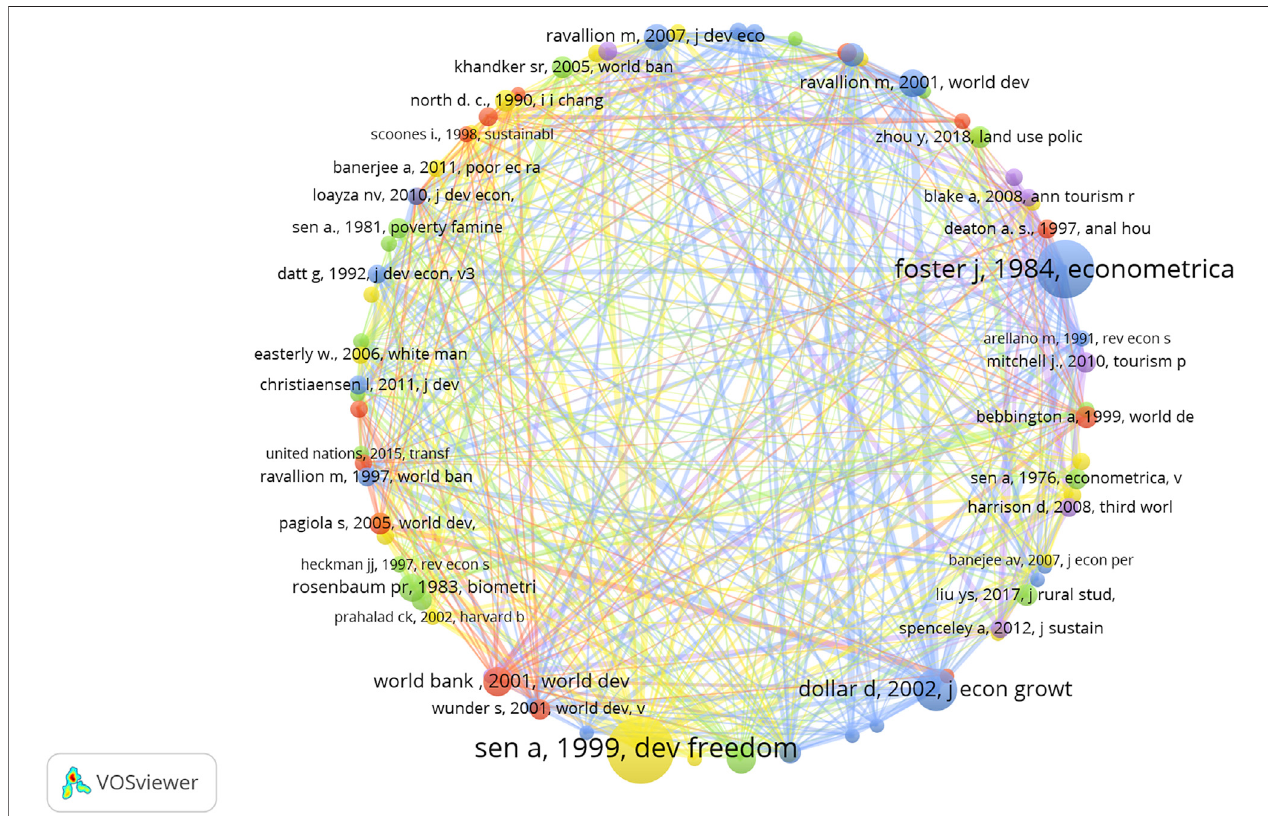
FIGURE 6 | Cited reference network of